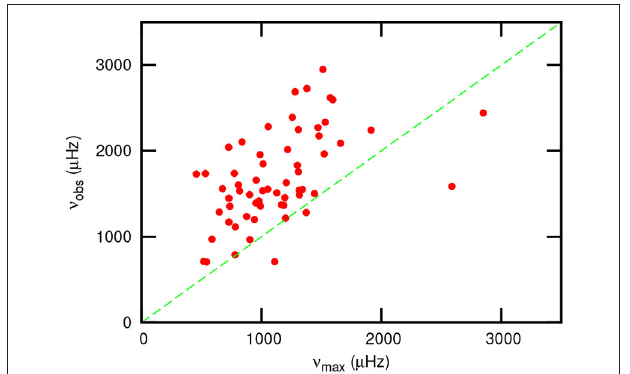
FIGURE 4 | Location of the roAp stars in the H-R diagram (filled circles) showing the δ Sct region of instability (large dotted polygon) and the γ Dor instability region (small dotted polygon within the δ Sct region). The three asterisks are roAp stars with low frequencies. The two slanted lines are the red and blue edges of the instability region calculated by Cunha (2002). The ZAMS for solar abundances from Bertelli et al. (2008) is shown. The cross at bottom left shows the estimated 1- σ error bars.